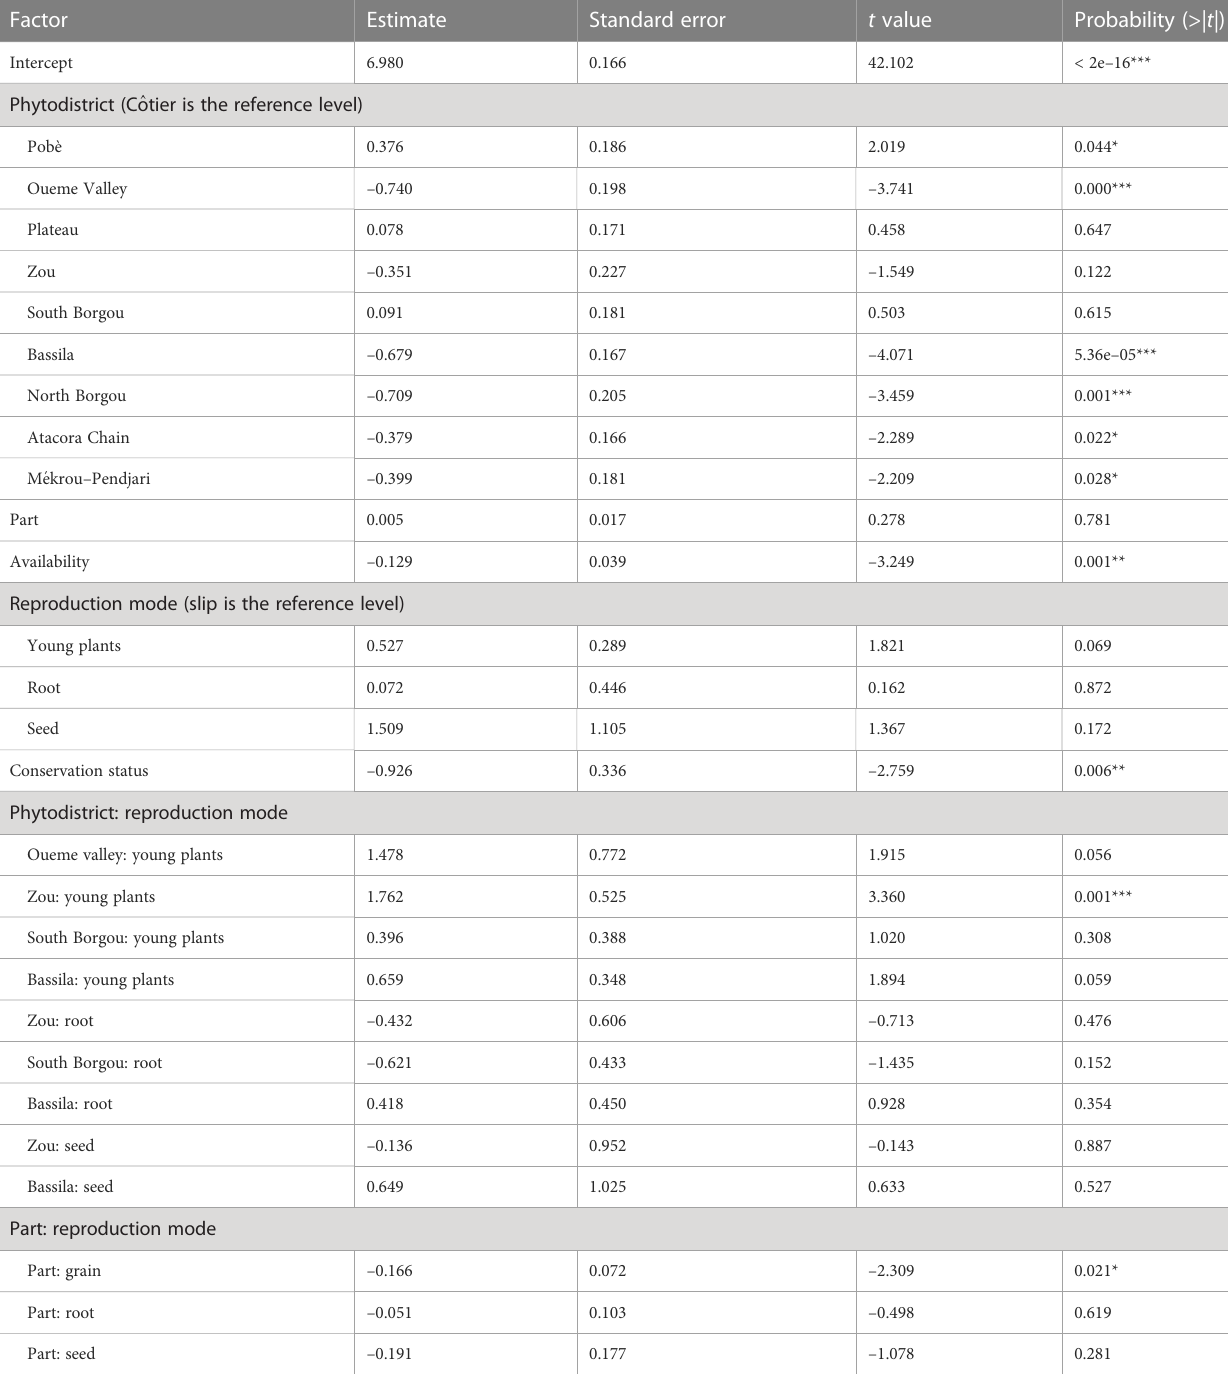
TABLE 4 Generalized linear model (GLM) output of the of the effects of species environment on ethnomedicinal